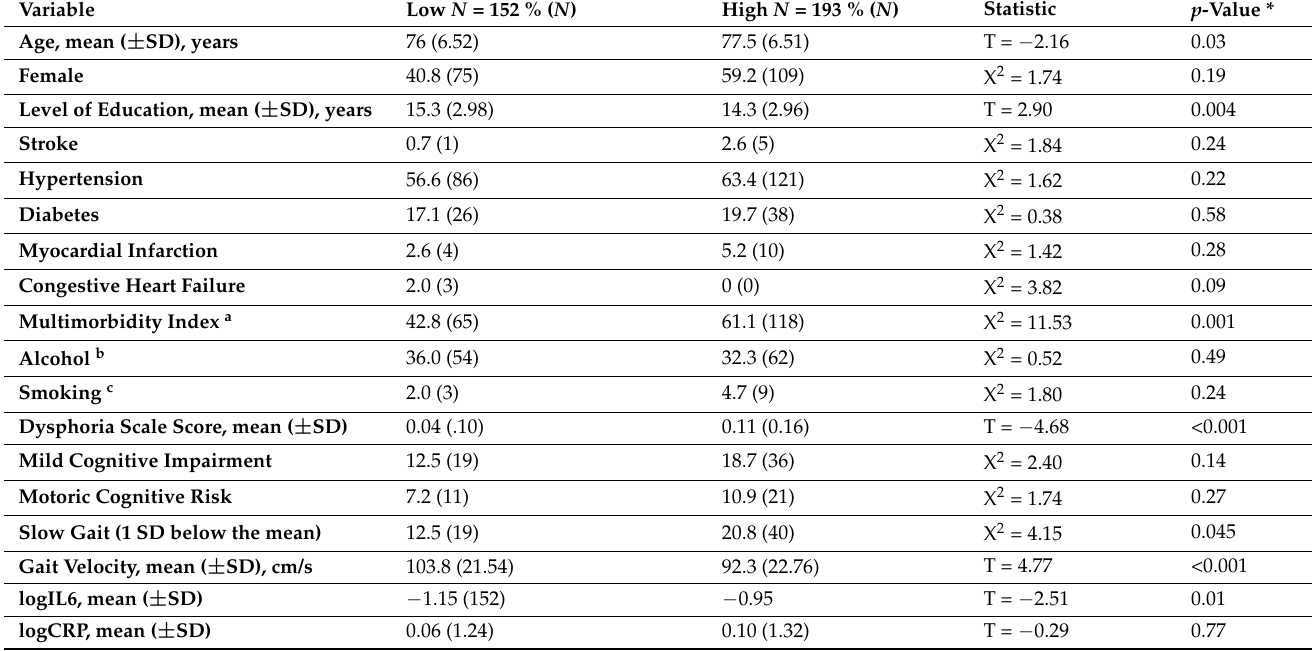
Table 1. Baseline characteristics of apathy scale